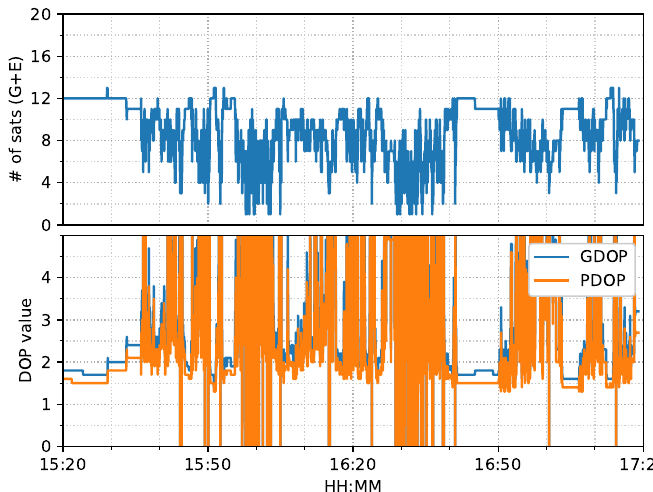
Figure 26. GNSS satellite information of city center test on 27 January 2022.